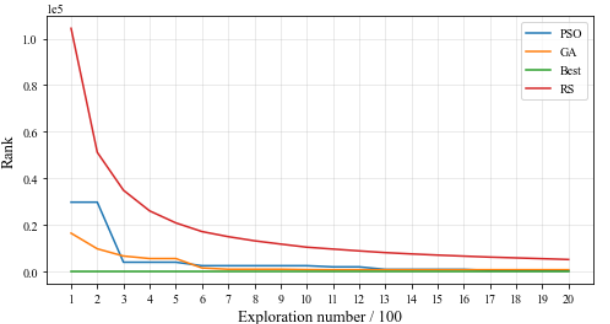
Figure 11. PMU placement ranking based on number of exploration—69-bus system, N m =